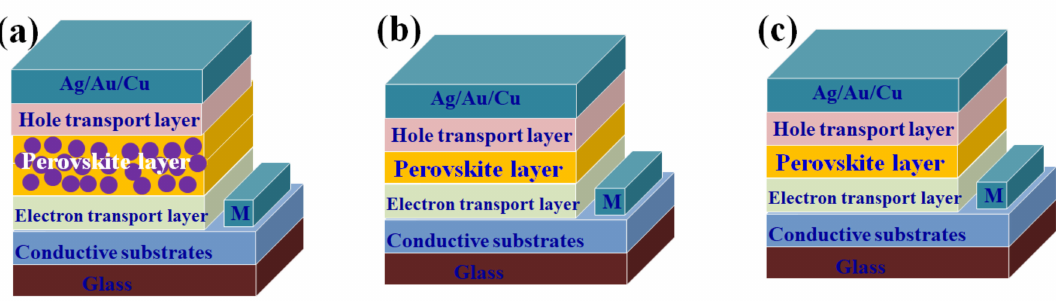
Figure 2. ( a ) mesoporous upright structure; ( b ) upright structure; ( c ) inverted